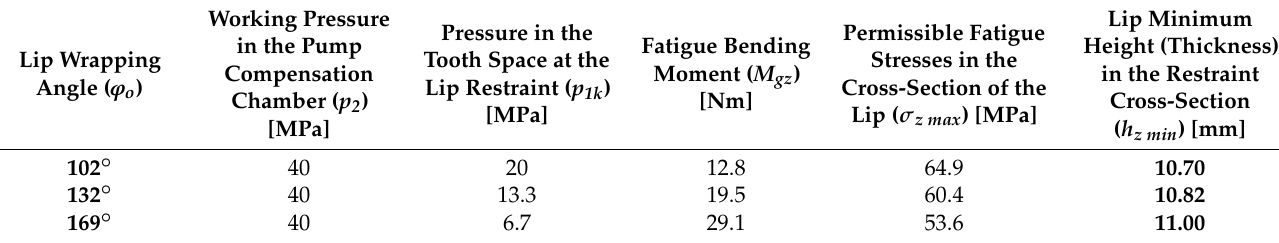
Table 1. Working parameters and results of fatigue calculations for three lip variants in a rotary pump with circumferential backlash compensation.